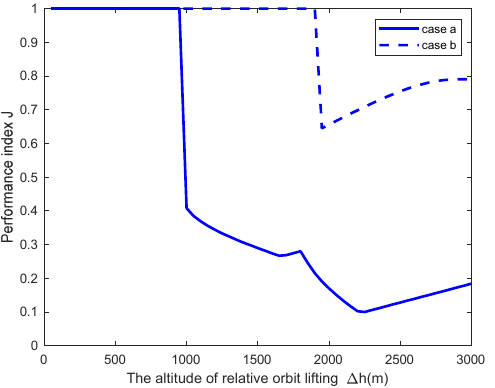
Figure 16. Weighted performance indexes of different collaborative observation configurations.